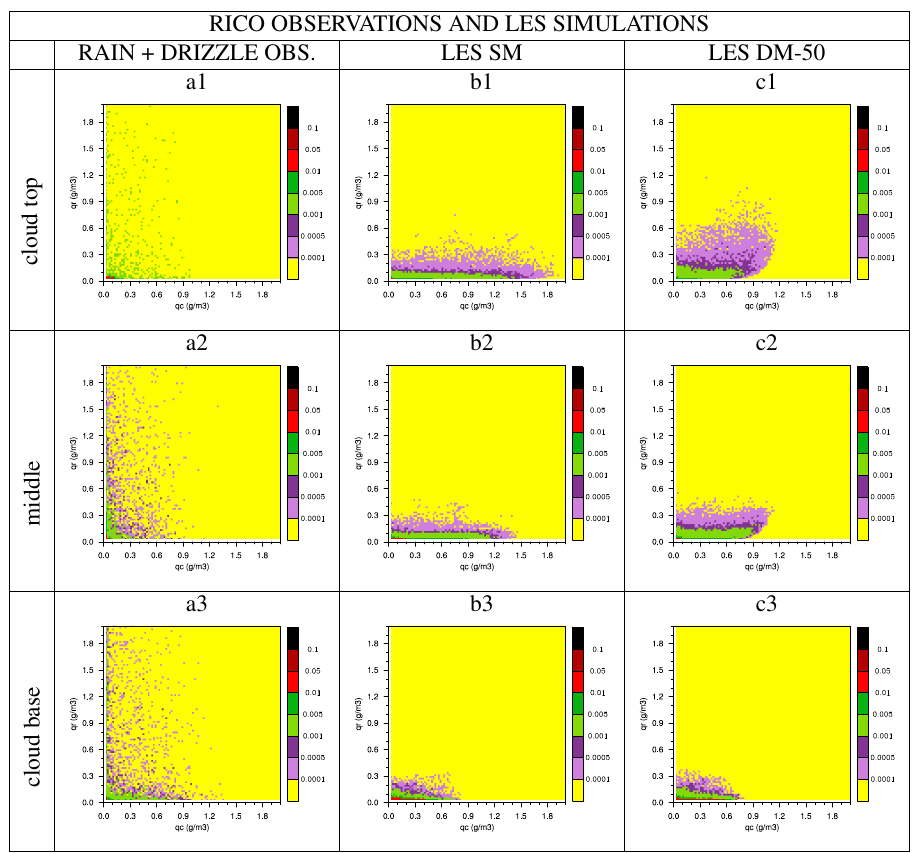
Figure 13: Same as Fig. 8 for RICO.